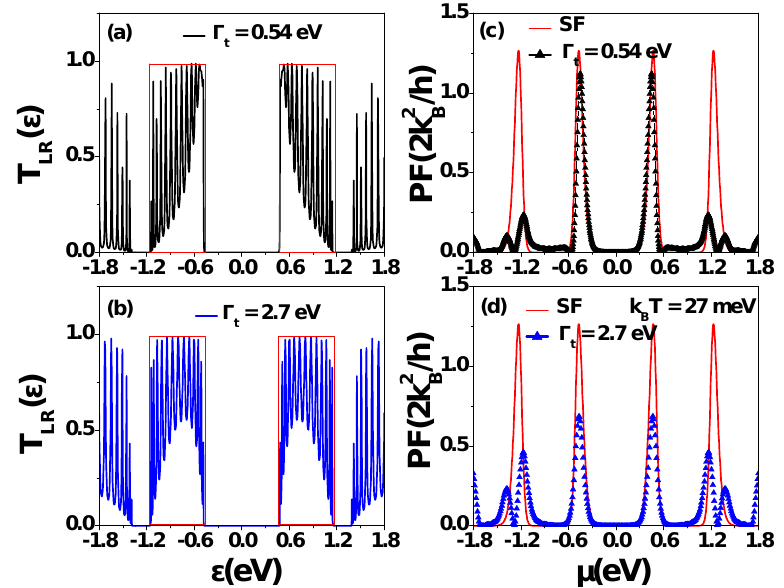
Figure 6. ( a , b ) Transmission coefficients T LR ( ε ) as functions of energy for a t-ZGNR with Γ t = 0.54 eV and Γ t = 2.7 eV. The T LR ( ε ) with square form (SF) is also plotted by a curve with red color. ( c , d ) Power factor as functions of µ for two tunneling rates at k B T = 27 meV. Other physical parameters are the same as those used in Figure